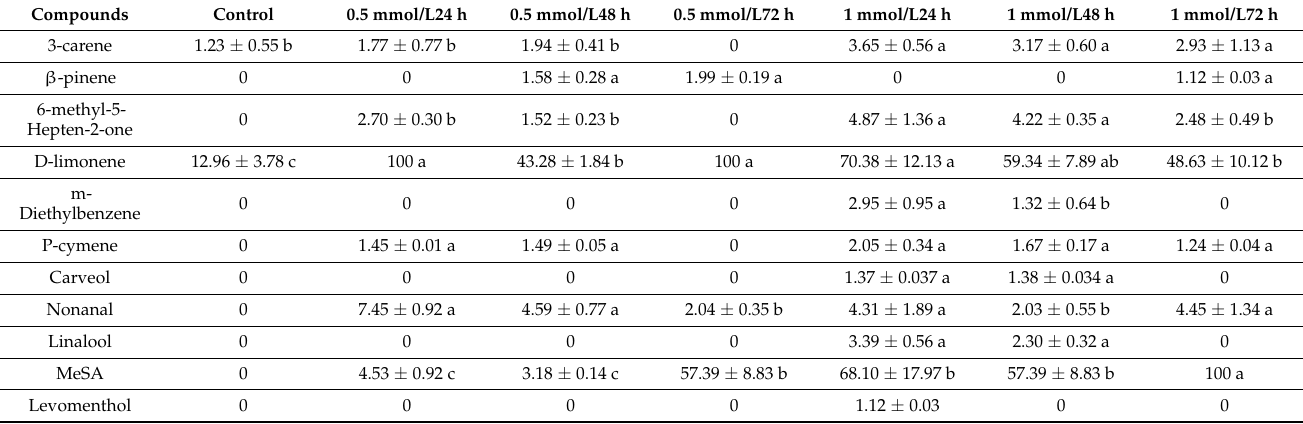
Table 2. The relative content analysis of volatiles.